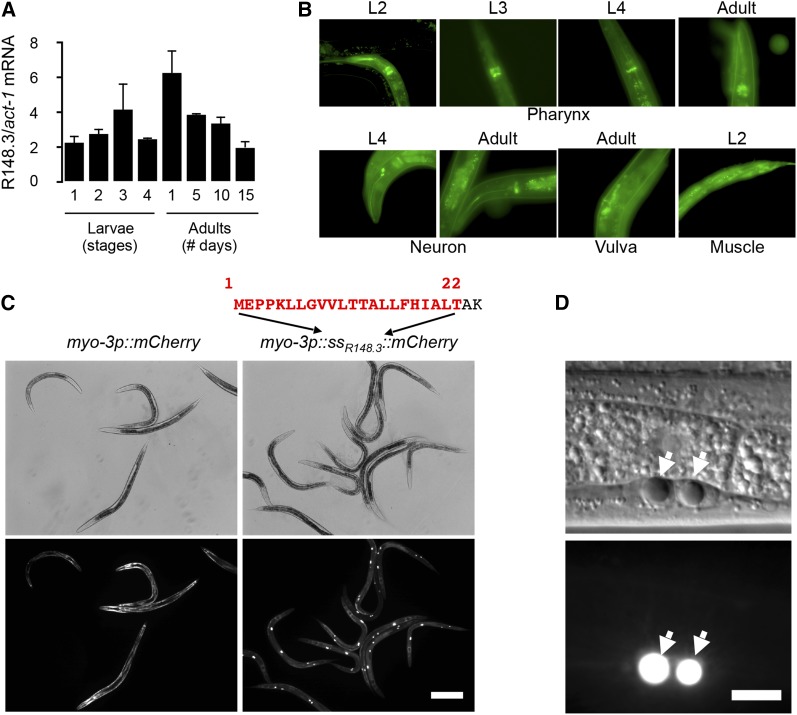
Expression of R148.3 in C. elegans. (A) Expression levels of R148.3 were measured by qPCR in N2 worms at different stages of their life; bars represent average ± SEM (n = 3). (B) Expression of a R148p::GFP reporter in the pharynx, neurons, vulva, and body wall muscles. Top panels: head is oriented up; lower panels: head is oriented down. (C) Representative images of mCherry fluorescence in muscle and coelomocytes in myo-3p::mCherry- vs. myo-3P::ssR148.3::mCherry-expressing worms. Exposure: 20 msec. Bar, 200 µm. (D) Representative image of myo-3P::ssR148.3::mCherry expression in coelomocytes. → indicates coelomocyte nuclei. Exposure: 1 msec. Bar, 10 µm. Similar findings were obtained with a second independent transgenic line.